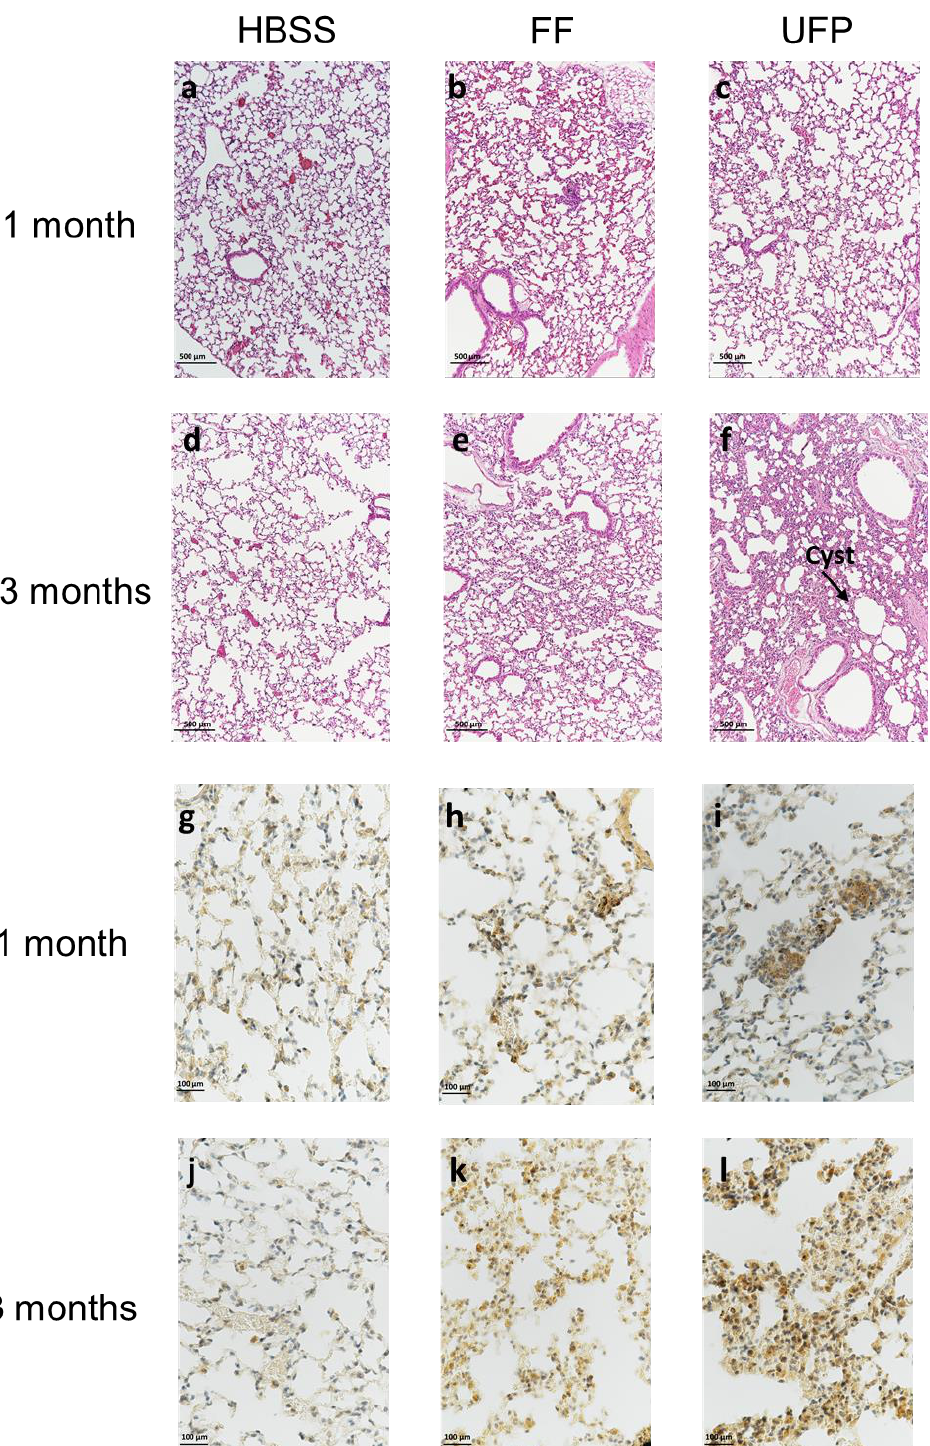
Figure 5. Lung tissue remodeling following exposure to FF or UFP after 1 or 3 months. (a – f) Lung histology (hematoxylin and eosin stain) showing alveolar wall thickening in mouse lungs; Cyst = cystic region; magnification 10×. (g – l) Immunohistochemical staining of mouse lungs; representative images of lung tissue sections stained for F4/80 (macrophages are stained brown); magnification 40×.